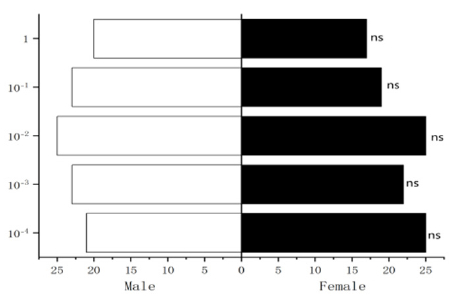
Figure 35. Comparison of behavioral responses of W. magnifica to propyl butyrate.